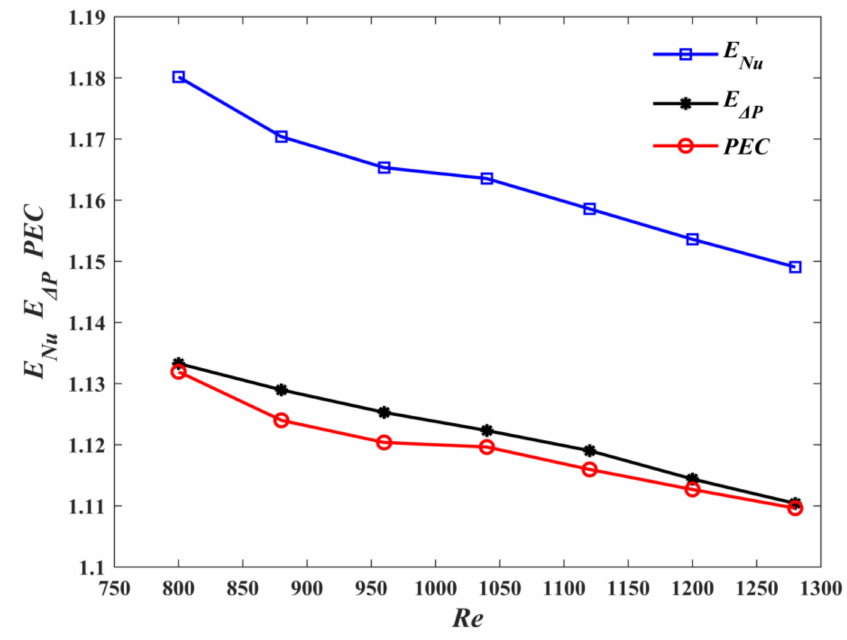
Figure 15. Effect of Re on E Nu , E ∆ P and PEC for